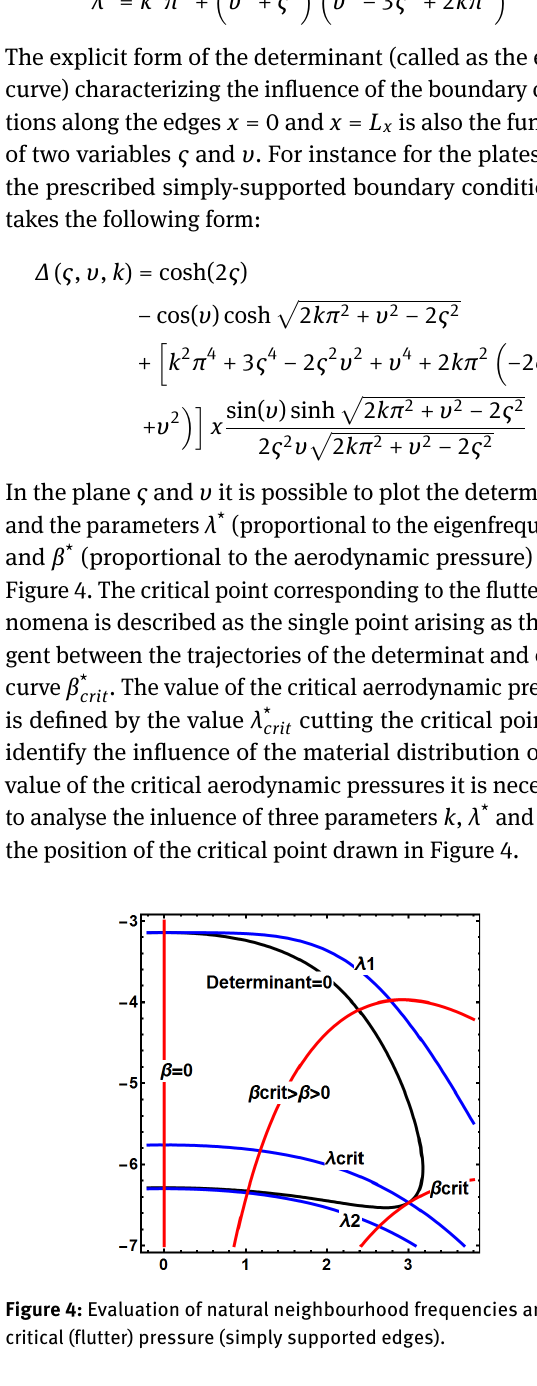
The effects of the parameter k can be easily derived plotting the values of the determinant (19) – Figure 5. The locations of the critical points are shifted as the value of k